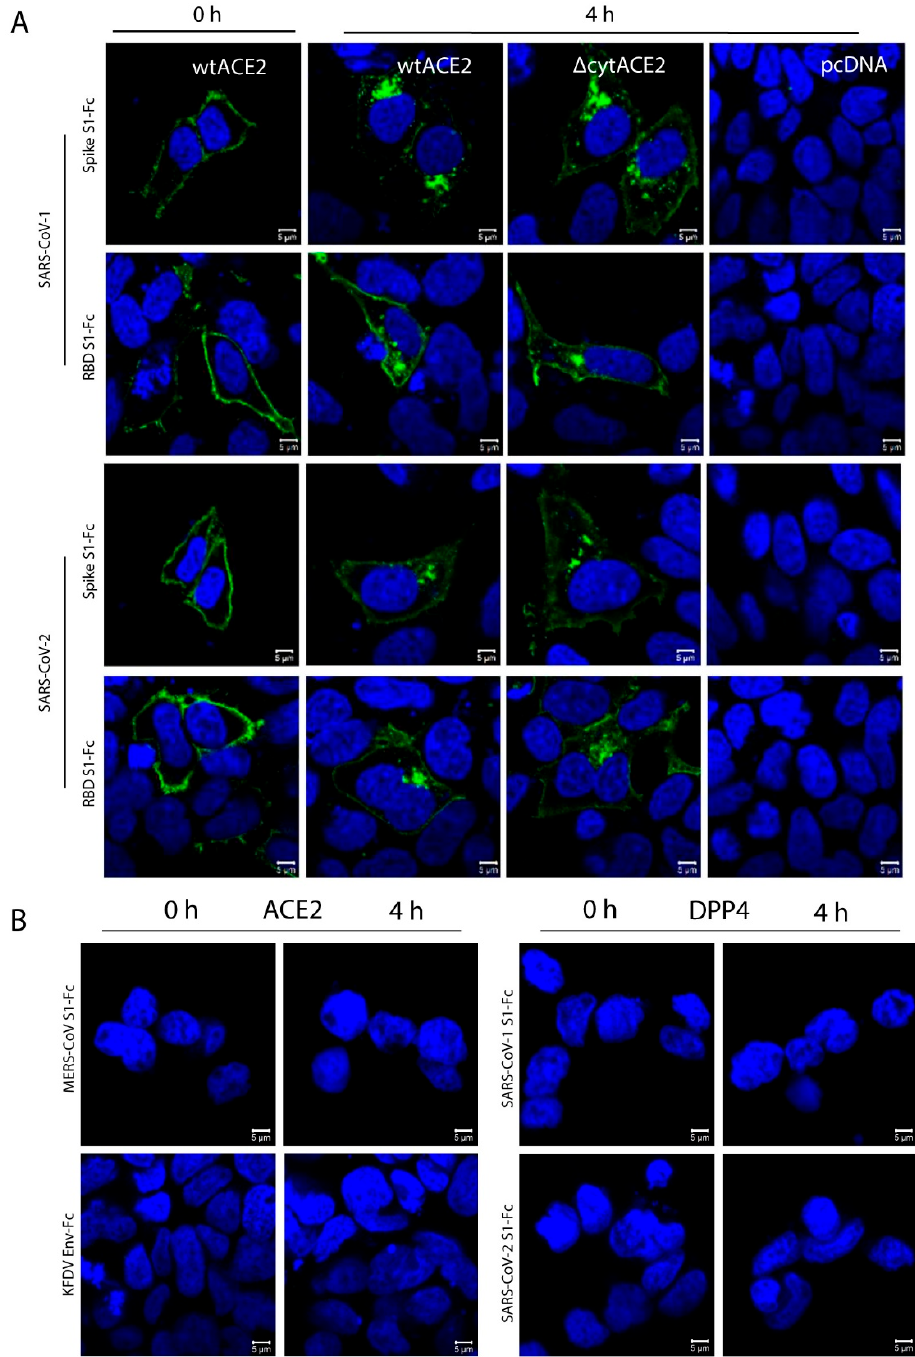
Figure 4. Cellular internalization of SARS-CoV-1 and -2 spike S1-Fc or RBD-Fc proteins. HEK293T cells were transfected independently with either wtACE2, ∆ cytACE2, or pcDNA plasmids. Following 24 h transfection, cells were incubated for 0 or 4 h with ( A ) spike S1-Fc or RBD-Fc proteins (3 µ g/mL) of SARS-CoV-1 or SARS-CoV-2 and then the S1-Fc proteins were stained with FITC-conjugated anti-human IgG and visualized under confocal microscopy. Similarly, ( B ) MERS-CoV S1-Fc or KFDV envelope protein Fc on wtACE2-expressing cells (left panel) and SARS-CoV-1 and -2 S1-Fc proteins on DPP4 (right panel). Nuclei were stained with DAPI (blue).